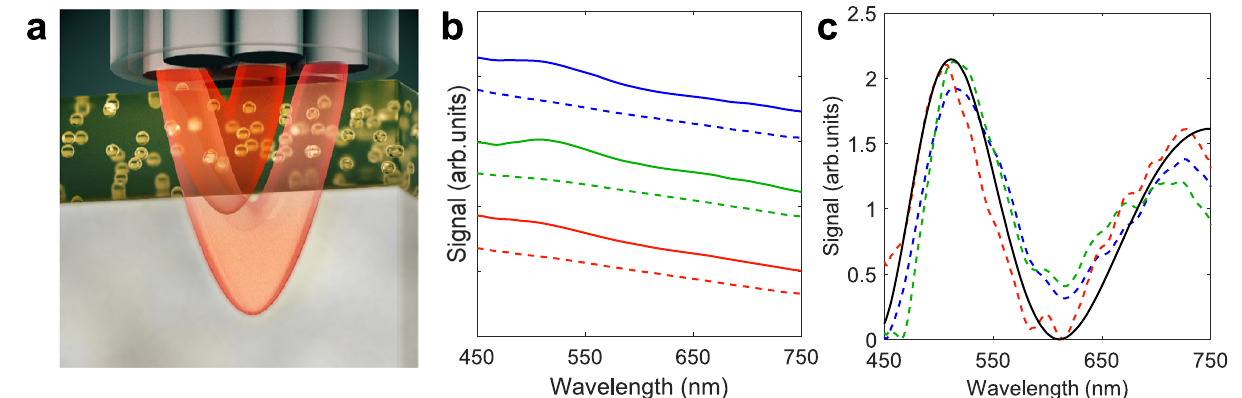
(green) and 2mm − 1 (blue). c Reconstructed single backscattering components of thetoplayerforbottomlayerswith1mm − 1 (red),1.5mm − 1 (green)and2mm − 1 (blue) reduced scattering coef fi cients and Mie theory calculations for 0.5 μ m diameter polystyrene microspheres in backscattering direction (black